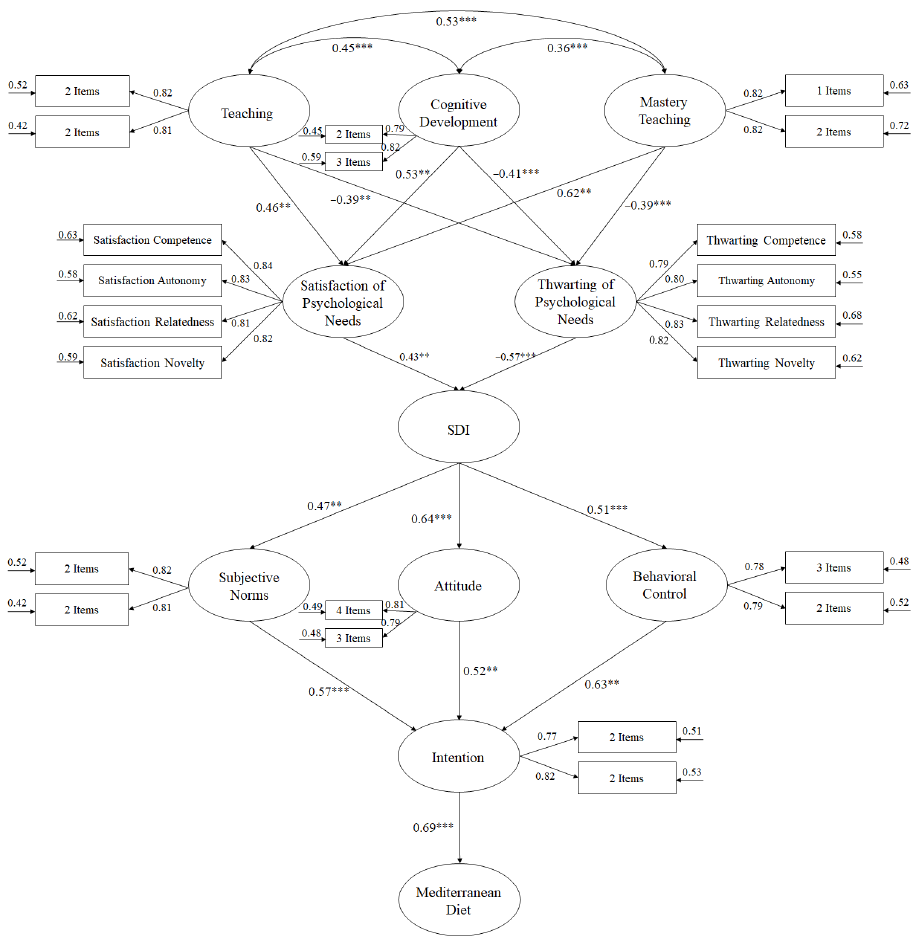
Figure 1. Predictive model. Structural equation model. Note: *** p < 0.001; ** p <